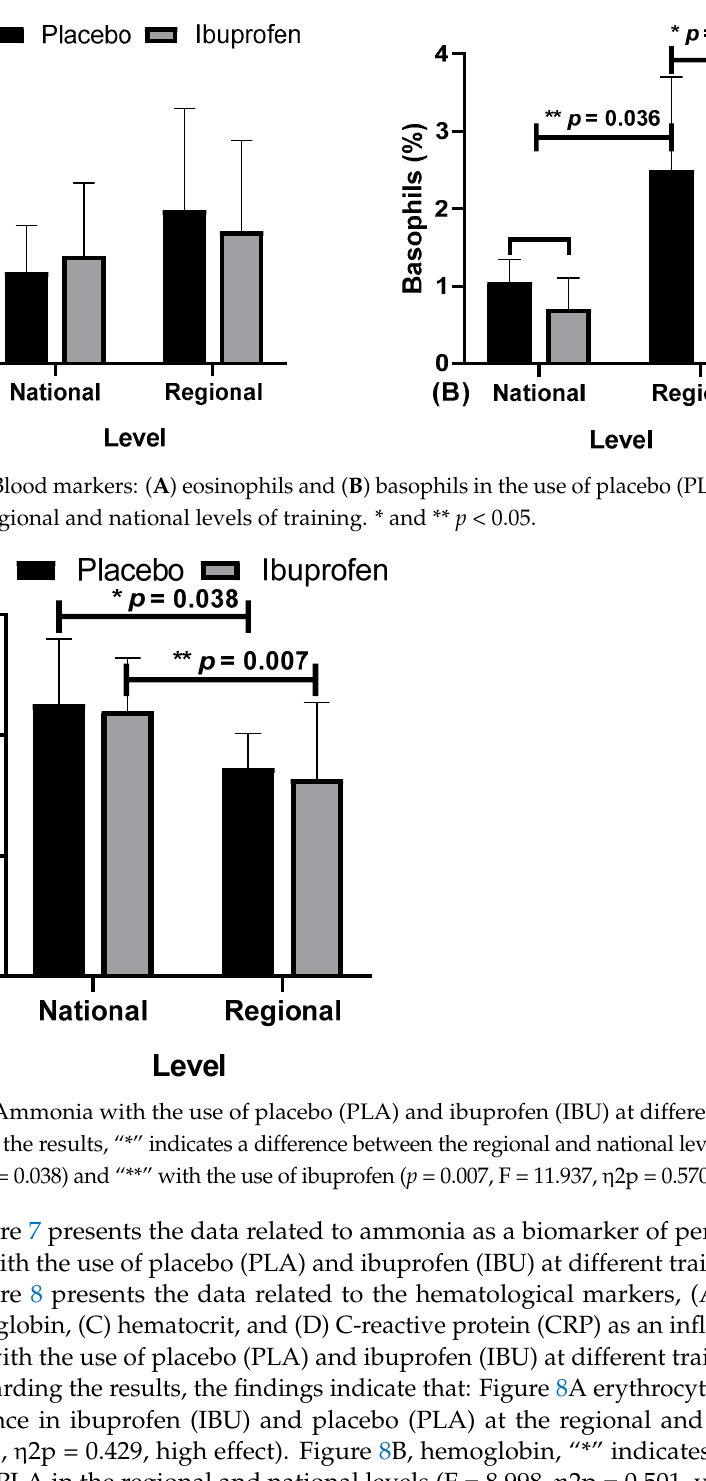
Figure 7. Ammonia with the use of placebo (PLA) and ibuprofen (IBU) at different training levels. Regarding the results, “*” indicates a difference between the regional and national levels with the use of placebo ( p = 0.038) and “**” with the use of ibuprofen ( p = 0.007, F = 11.937, η 2p = 0.570, very high effect).